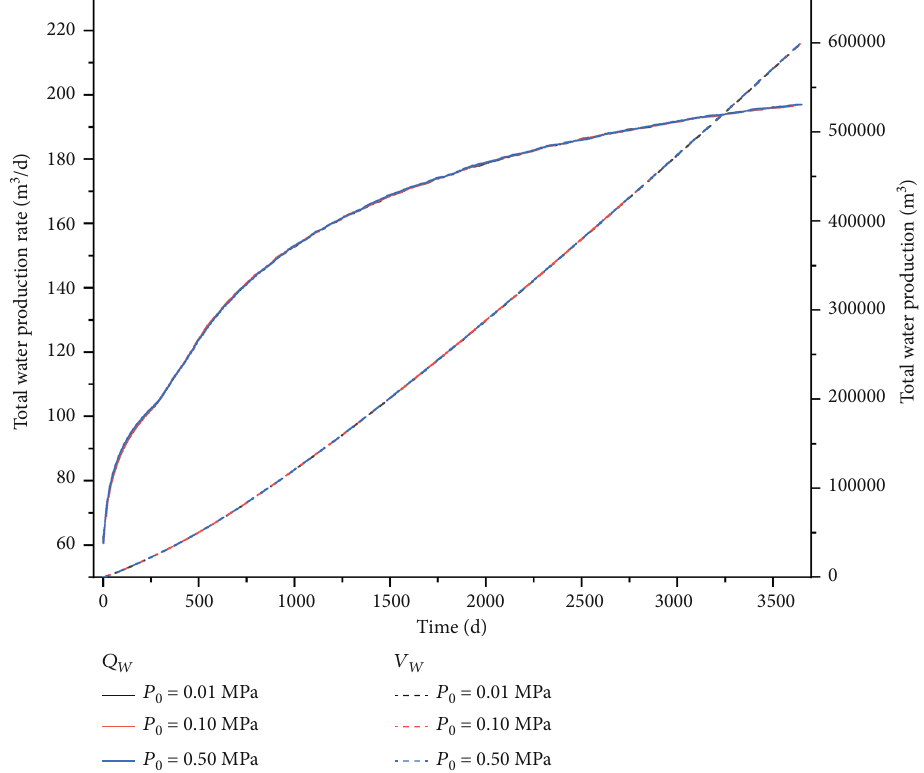
Figure 17: Evolution of total water production rate Q